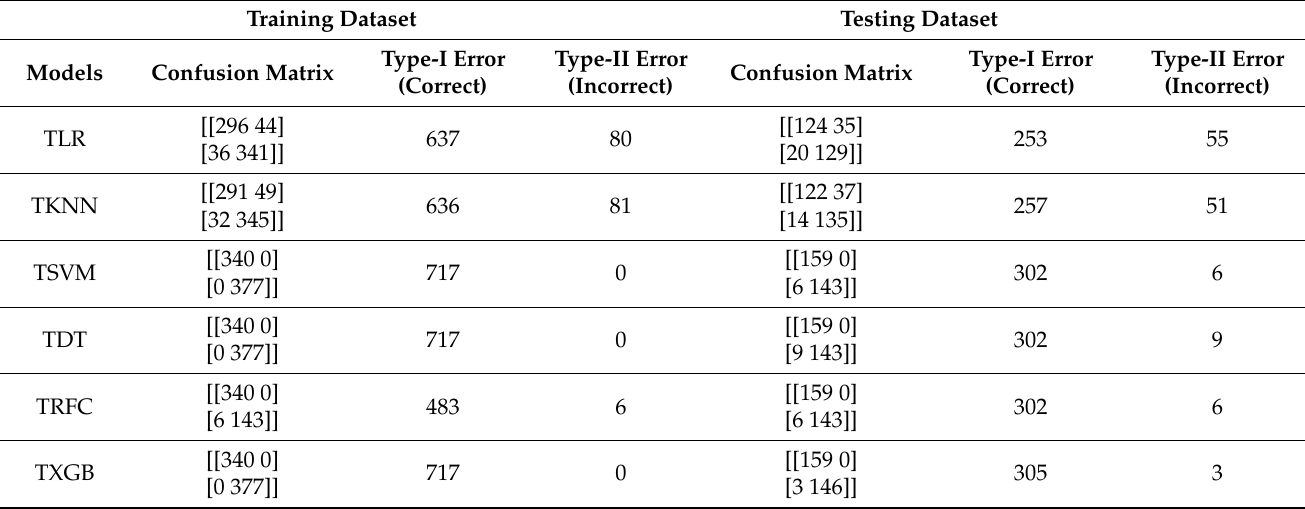
Table 12. Performance evaluation and comparison of the confusion matrix after using a hyperparam- eter tuning approach on the training and testing